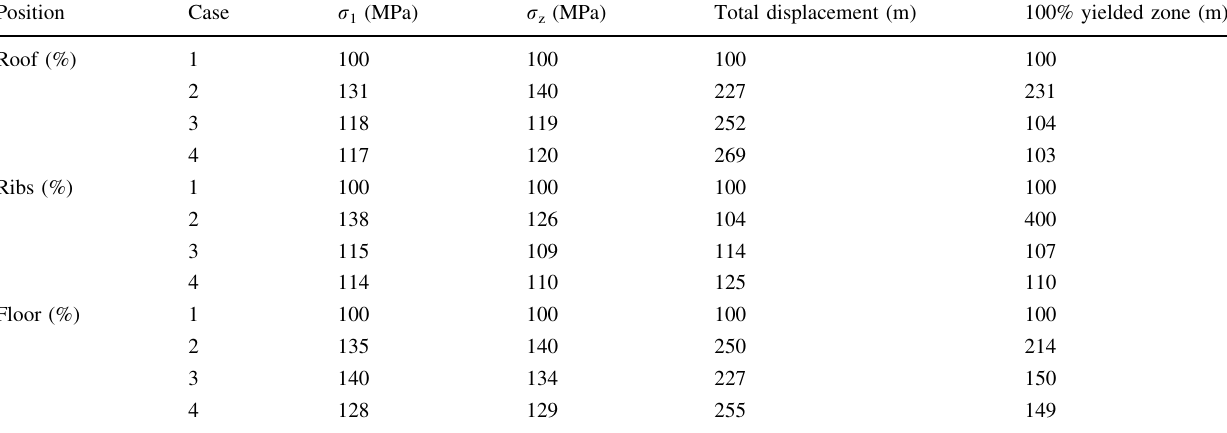
Table 2 Percentage differences between the results derived from the numerical model (the results from Case 1 are assumed to be 100%)